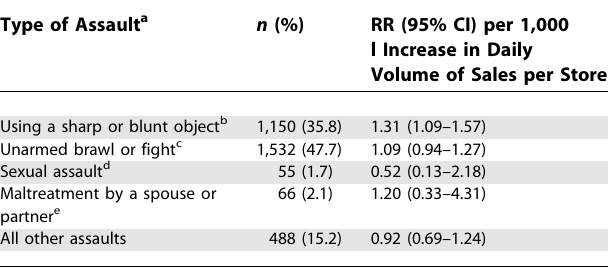
Table 3. Risk of Hospitalization for Assault, in Association with Daily Sales of All Forms of Alcohol, by Type of Assault Type of Assault